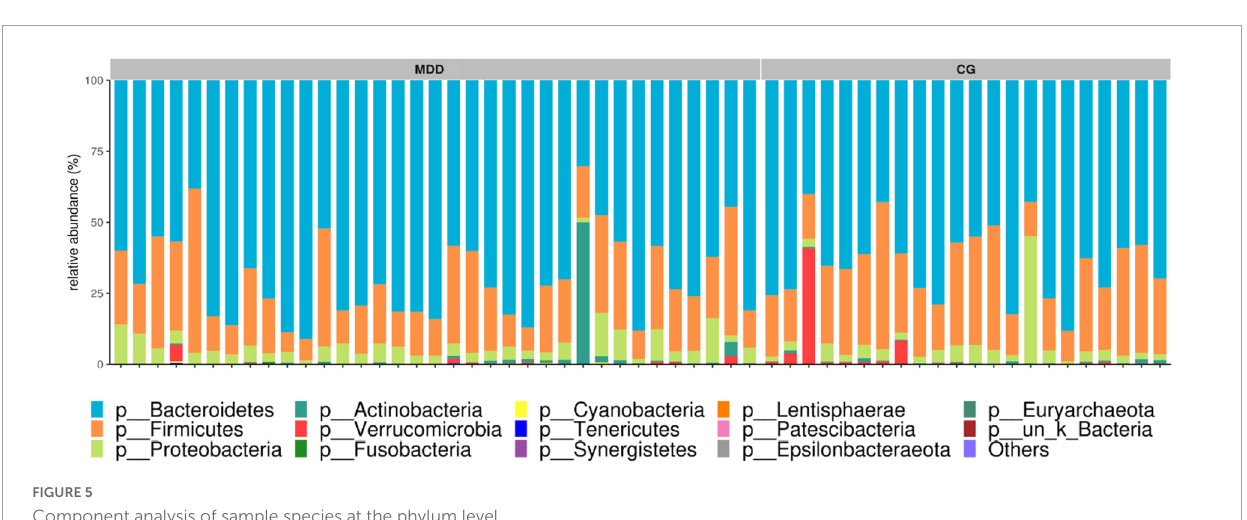
FIGURE5 Component analysis of sample species at the phylum